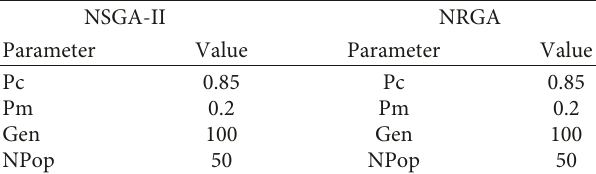
Figure 5: Values of different levels of parameters in the S/N ratio for NRGA. Table 5: Best value of parameters for NSGA-II and